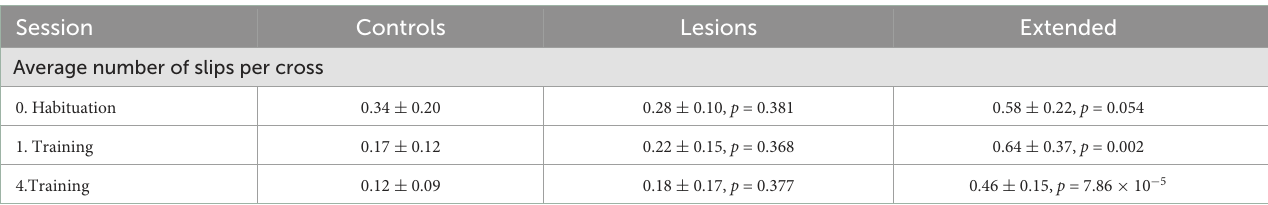
TABLE 3 Average number of slips per crossing of each group for sessions with stable obstacles (mean ± standard deviation, p -values report Student’s unpaired t -test against the control group).